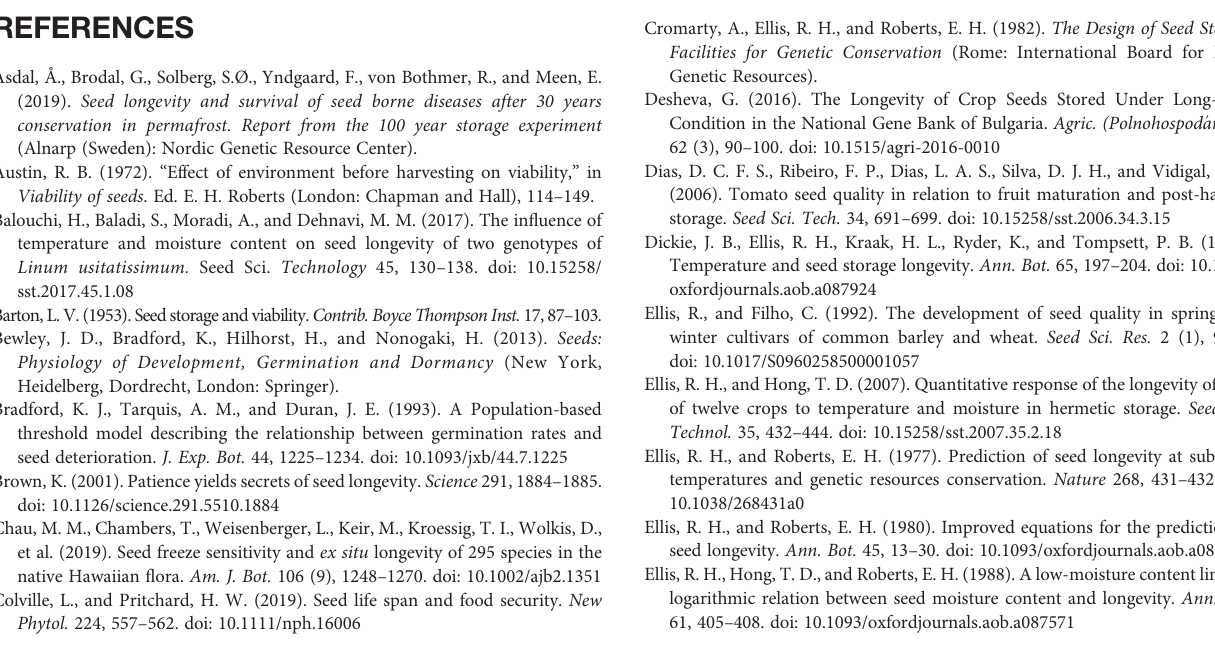
TABLE S1 | Supplementary fi le with data from the meta-analysis showing all species, number of accessions per species, initial germination percentage, storage years, fi nal germination percentage, average yearly changes in germination and observed/estimated P 50 from each of the studies included. See text for explanation. TABLE S2 | Supplementary fi le with predicted fi nal germination data from the SeedInformationDatabasefromRBGKewcompared toobserved fi nal germination data from the given long-term studies included in our meta-analysis. See text for explanation. TABLE S3 | Supplementary fi le withdata for the different terminal nodes in the tree regression analysis (last column). Species information, number of accessions per species, initial germination percentage, storage years, fi nal germination percentage, average yearly changes in germination and observed/estimated P 50 from each of the studies included. See text for